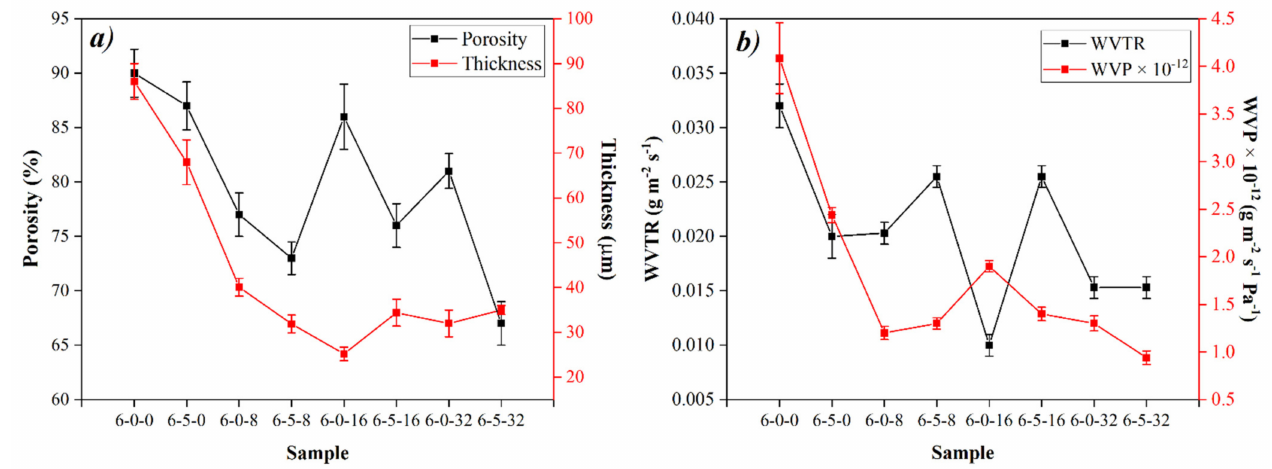
Figure 4. ( a ) Thickness and porosity of the membranes and ( b ) barrier properties of the membranes.